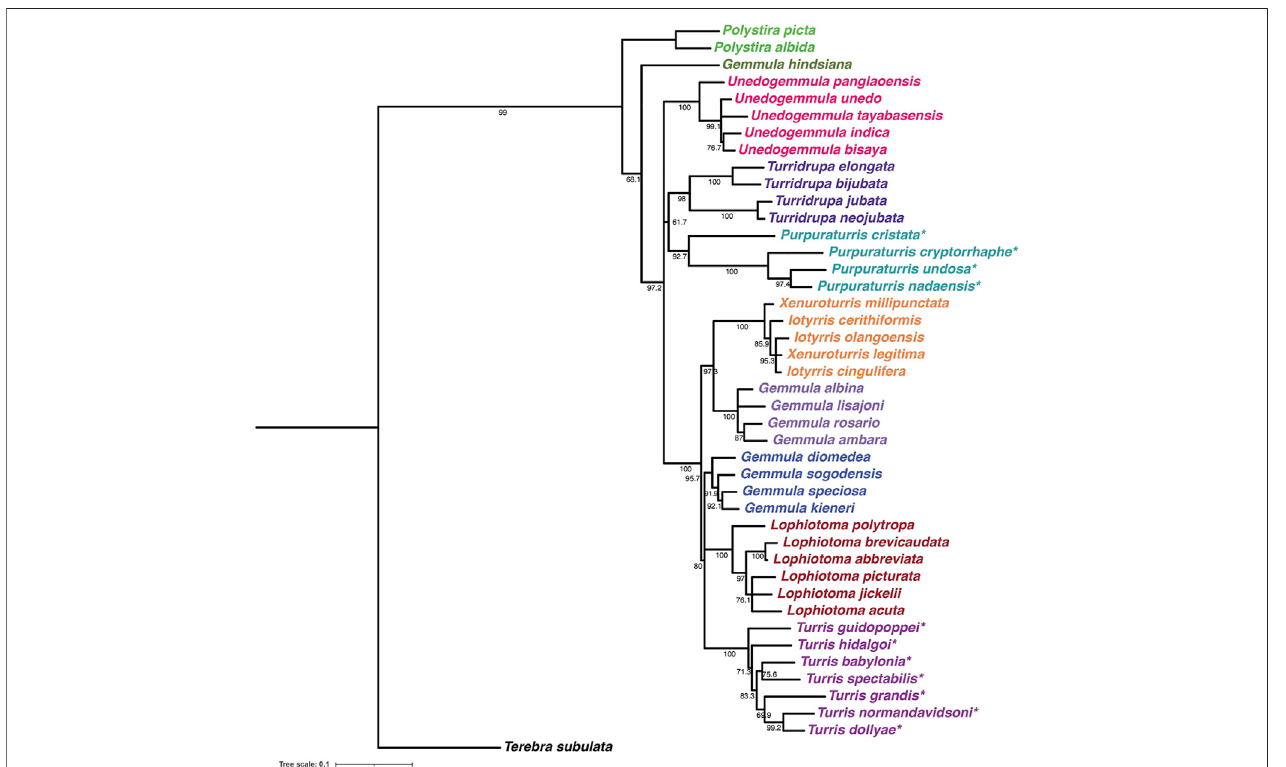
FIGURE 4 | Maximum likelihood phylogenetic tree of Turridae with bootstrap support values. The tree uses standard phylogenetic markers (the GenBank accession numbers and publication references are listed in Supplementary Table S5 ) and was constructed as described under Methods. We have marked with an asterisk the species that were formerly assigned to the genus Turris ; as shown in the tree, these are widely separated into two groups, Turris , colored purple (now all assignedto thegenus Turrissenso stricto ) and the turquoise branch (assigned tothe new genus Purpuraturris gen. nov. ) The treeillustrates someofthe remaining taxonomic problems in Turridae: note that species conventionally assigned to Gemmula fall in multiple branches, while there is no separation between Xenuroturris and iotyrris .